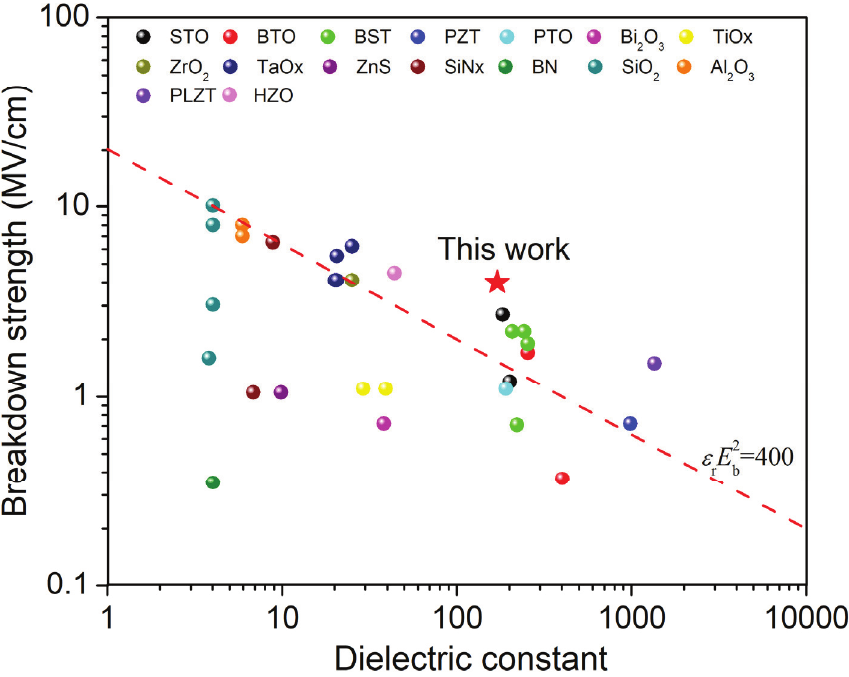
Figure 4. Electric breakdown field ( E b ) as a function of dielectric constants ( ε r ) for a variety of the dielectric thin-films. The data are from previously published literature.